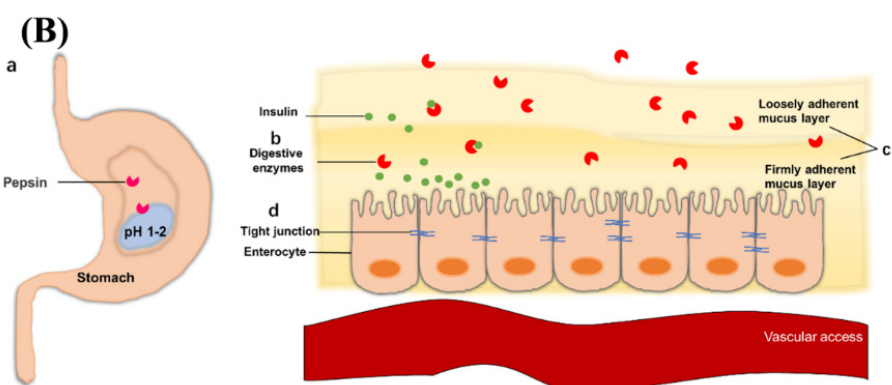
Figure 1. ( A ) Materials and nanostructures of oral insulin delivery systems. ( B ) The physiological absorption barrier of oral administration of insulin. ( a ) Destruction by gastric acid. ( b ) Degradation by digestive enzyme. ( c ) Retention by the mucus layer barrier. ( d ) Retardation by intestinal epithelial cell layer.